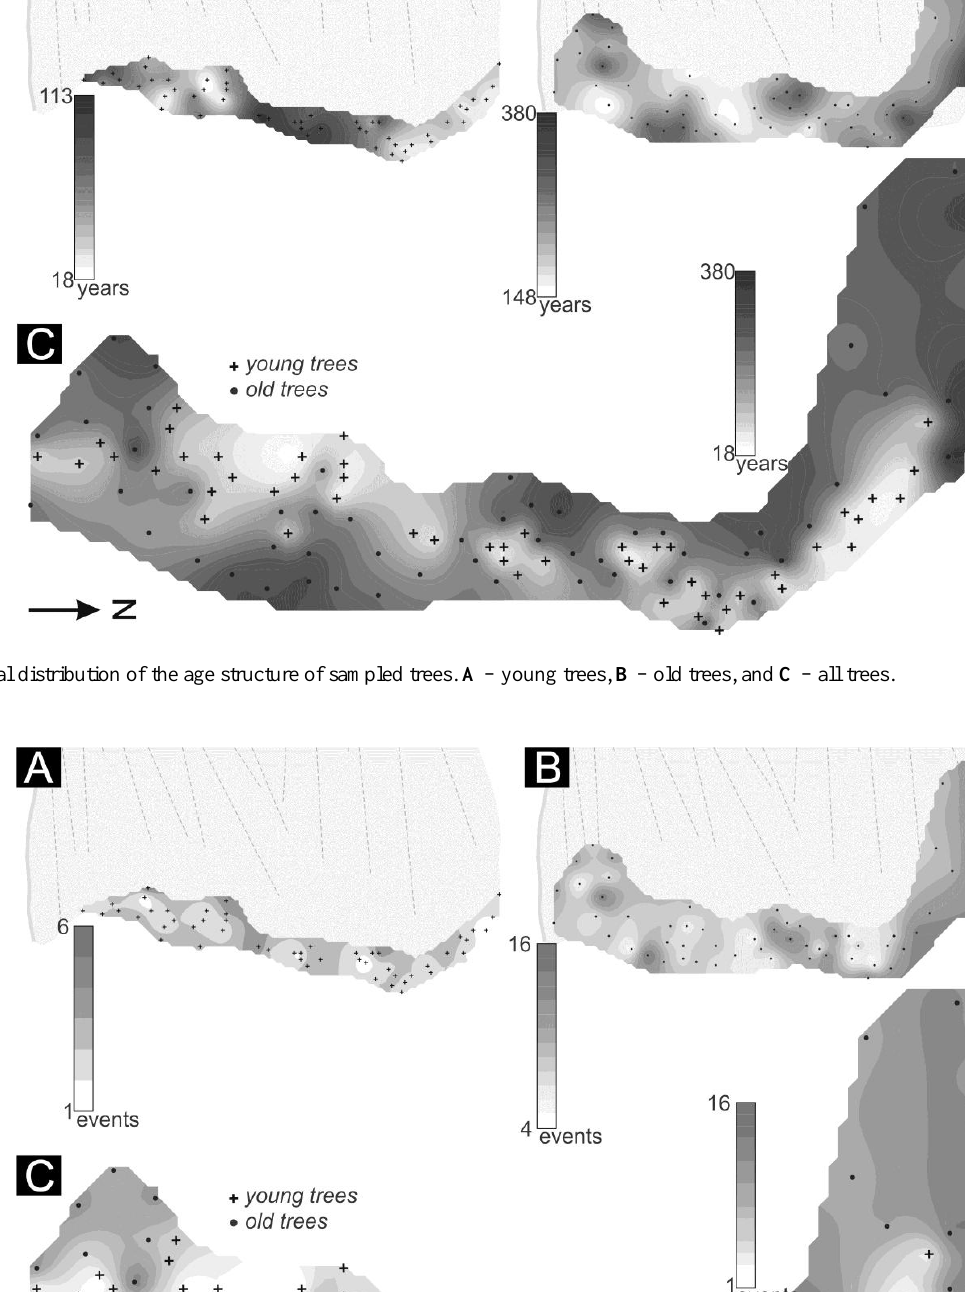
Figure 5: Spatial distribution of rockfall events recorded within individual trees (R young trees, B – old trees, C – all trees. 541